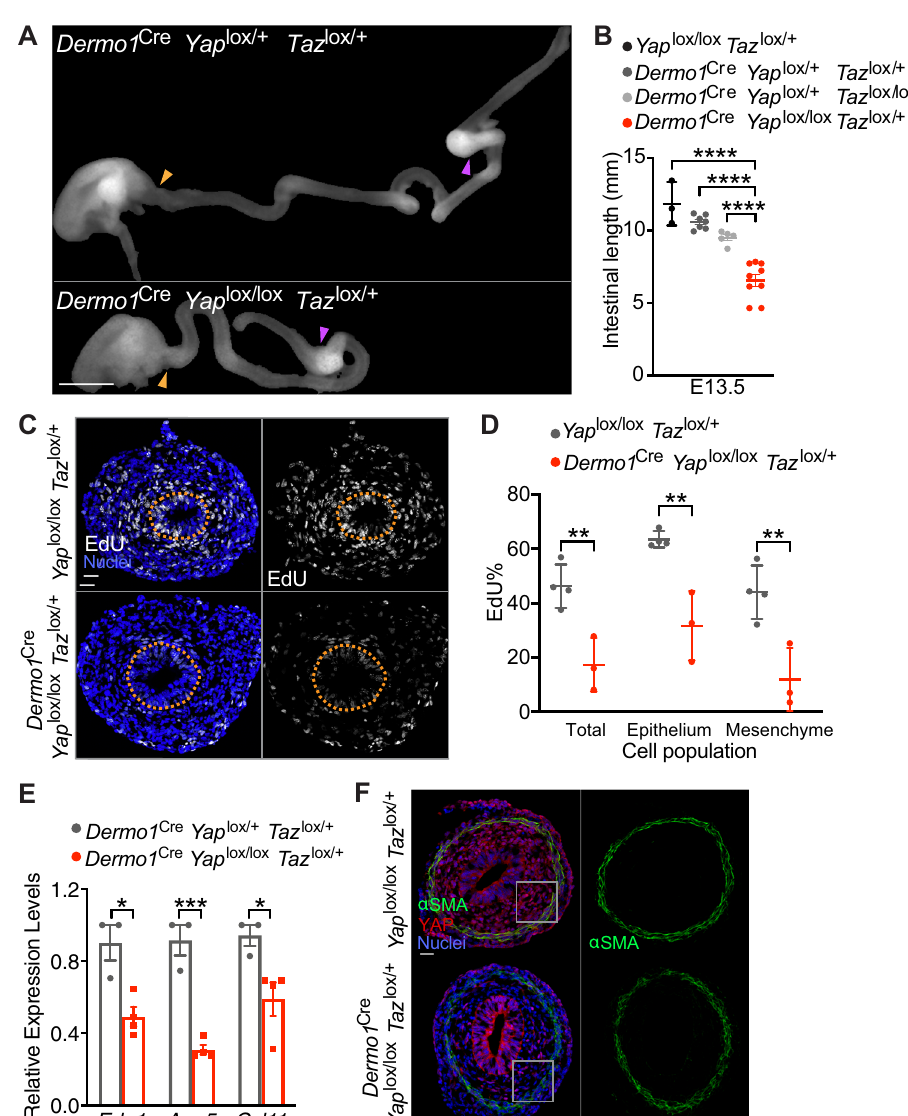
Fig. 5 YAP functions in the mesenchyme to promote gut elongation and cell proliferation. A Photos of E13.5 Dermo1 Cre Yap lox/ + Taz lox/ + and Dermo1 Cre Yap lox/lox Taz ox/ + intestines. Scale bar, 1 mm. The length of the small intestine was measured from the caudal stomach (orange arrowheads) to the rostral cecum (purple arrowheads). B Lengths of E13.5 in Yap lox/lox Taz lox/ + ( n = 3), Dermo1 Cre Yap lox/ + Taz lox/lox ( n = 7), Dermo1 Cre Yap lox/ + Taz lox/ + ( n = 5) and Dermo1 Cre Yap lox/lox Taz ox/ + ( n = 9) intestines. Horizontal bars indicate means ± SD. **** p < 0.0001 by one-way ANOVA Sidak ’ s multiple comparisons test. C Immuno fl uorescence staining of E12.5 Yap lox/lox Taz lox/ + and Dermo1 Cre Yap lox/lox Taz lox/ + intestines for EdU (white) and nuclei (Hoechst, blue). Scale bar, 25 μ m. Orange dotted lines outline the epithelium. D The percentage of EdU-positive cells in the E12.5 whole intestine, the epithelial cells or the mesenchymal cells in Yap lox/lox Taz lox/ + ( n = 4) and Dermo1 Cre Yap lox/lox Taz lox/ + ( n = 3). For each intestine, we averaged the percentages in the indicated cell population from three stained sections. Horizontal bars indicate means ± SD. ** p < 0.01 by two-way ANOVA Sidak ’ s multiple comparisons test (adjusted P are 0.0031 for Total, 0.0014 for Epithelium and 0.0013 for Mesenchyme). E Relative levels of End1 , Ano5 , and Ccl11 mRNA in E13.5 control ( Dermo1 Cre Yap lox/ + Taz lox/ + , n = 3) and Dermo1 Cre Yap lox/lox Taz lox/ + ( n = 4) intestines. Values are presented as means ± SEM. * p < 0.05 and *** p < 0.001